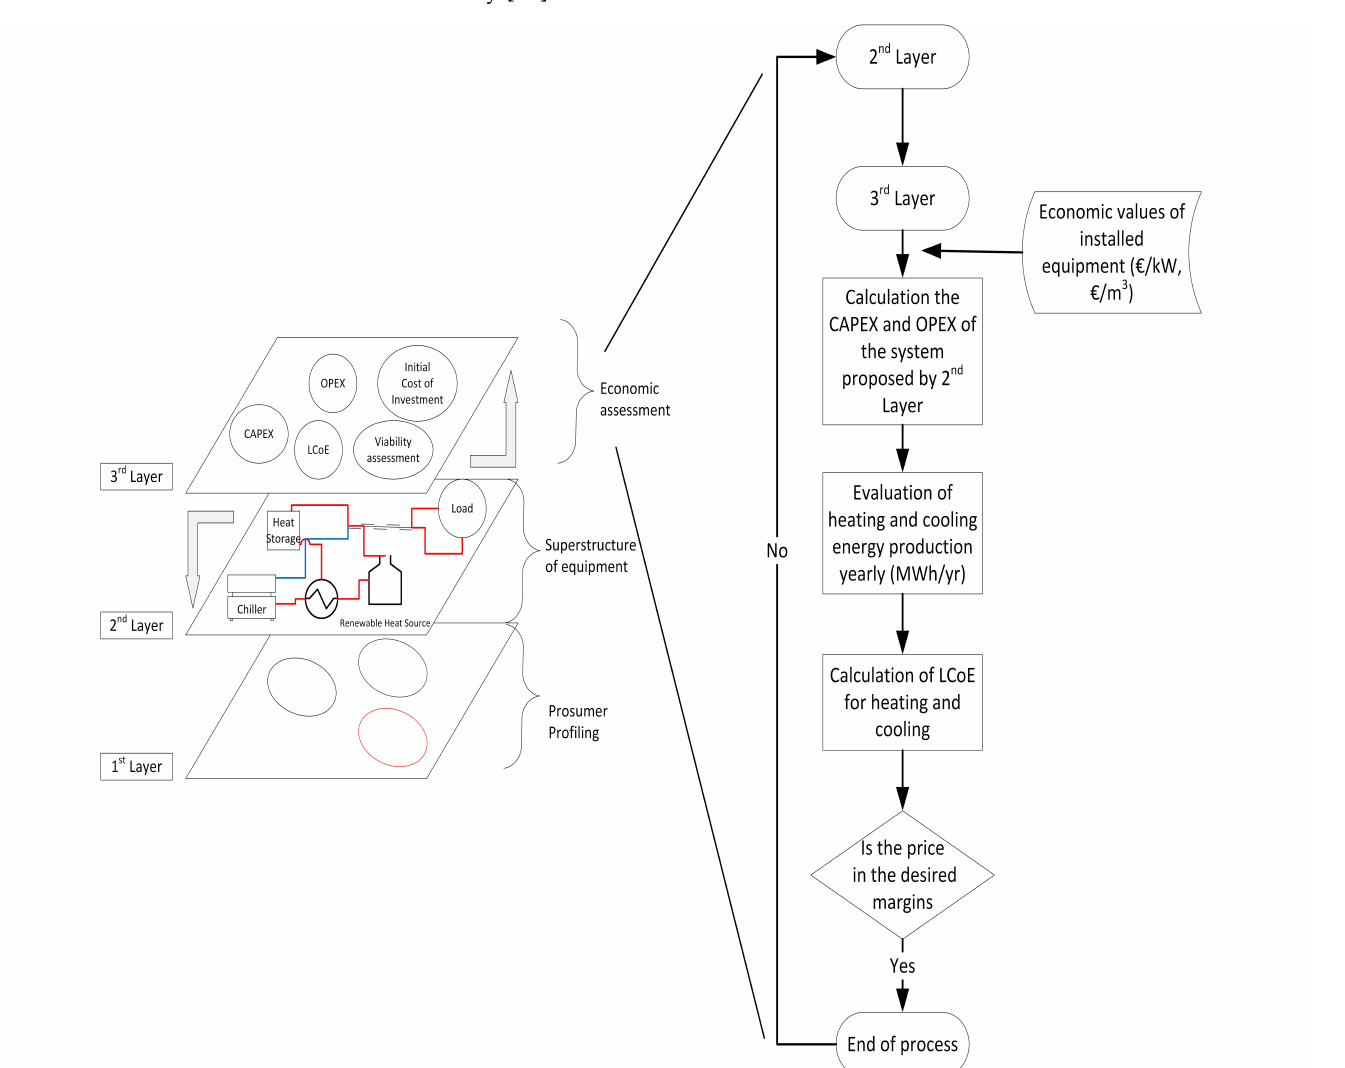
Figure 5. Flowchart representing the research procedure of the 3rd layer of